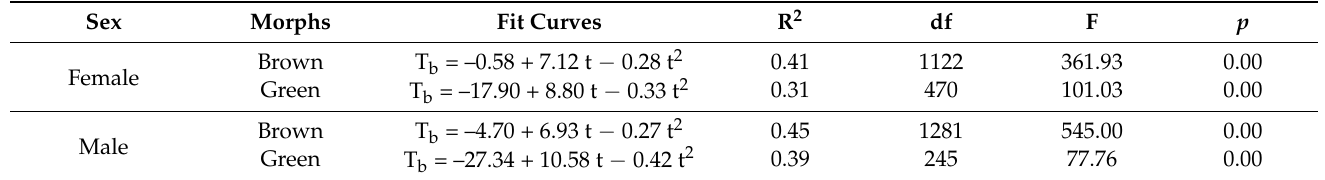
Table 2. Non-linear body temperature model parameter estimates for Oedaleus decorus